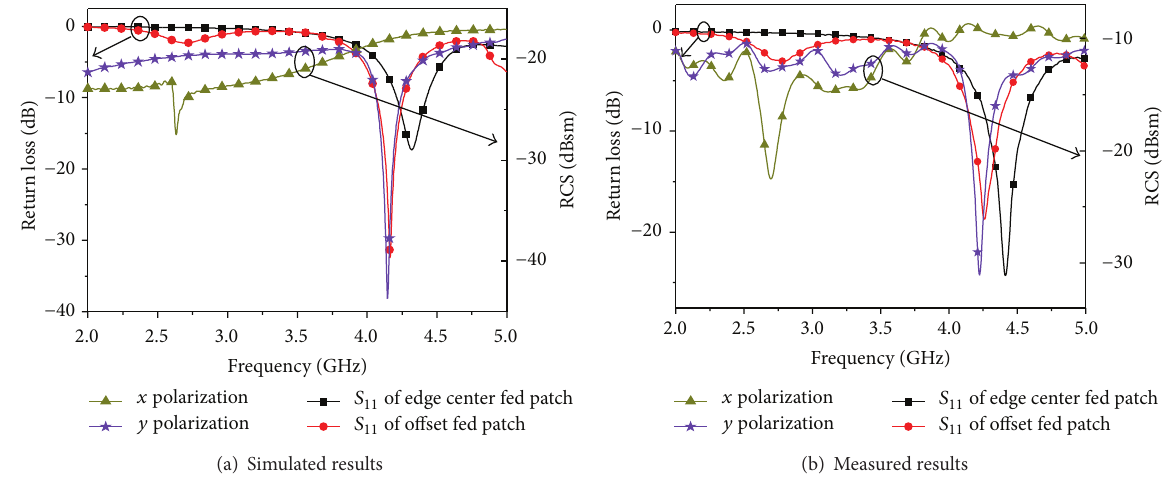
Figure 2: Monostatic RCS and 𝑆 11 of the antennas in Figure 1 for two feeding cases, where the 𝑥 - and 𝑦 -polarized plane waves are incident to the normal